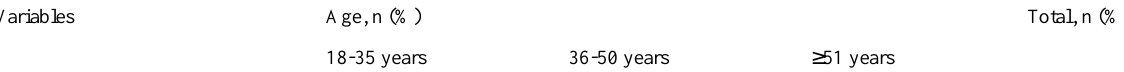
Table 9. Accounting some questions according to age of participants (N=516).